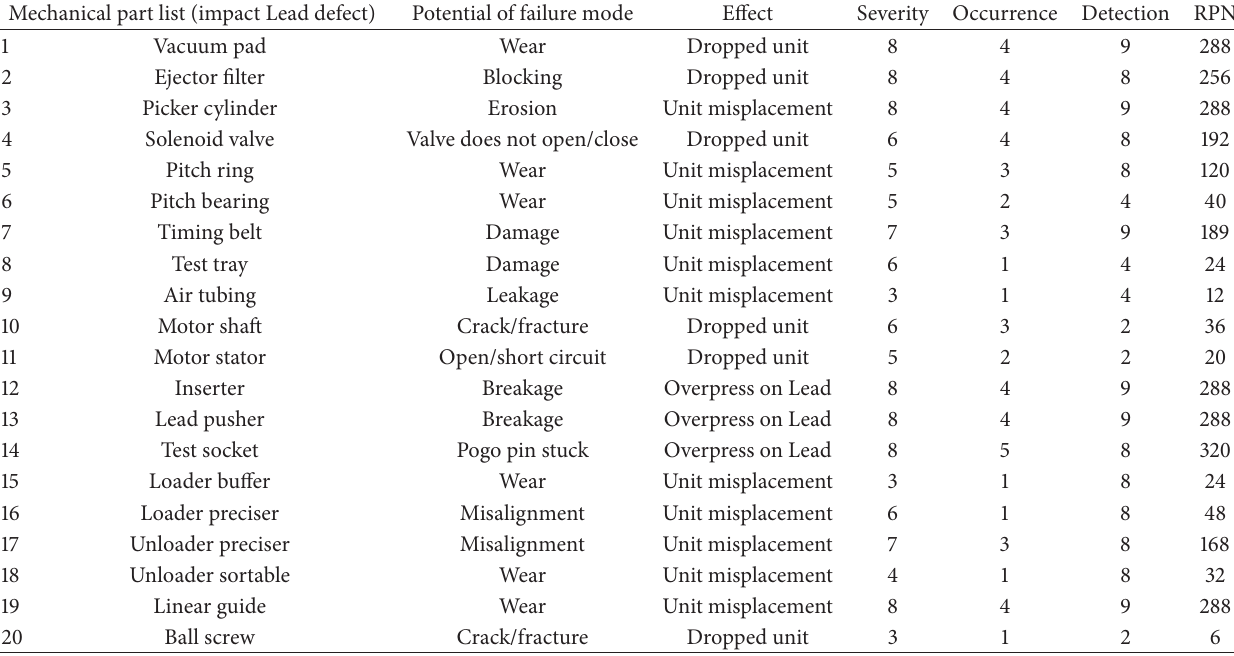
Table 4: FMEA worksheet for test machine